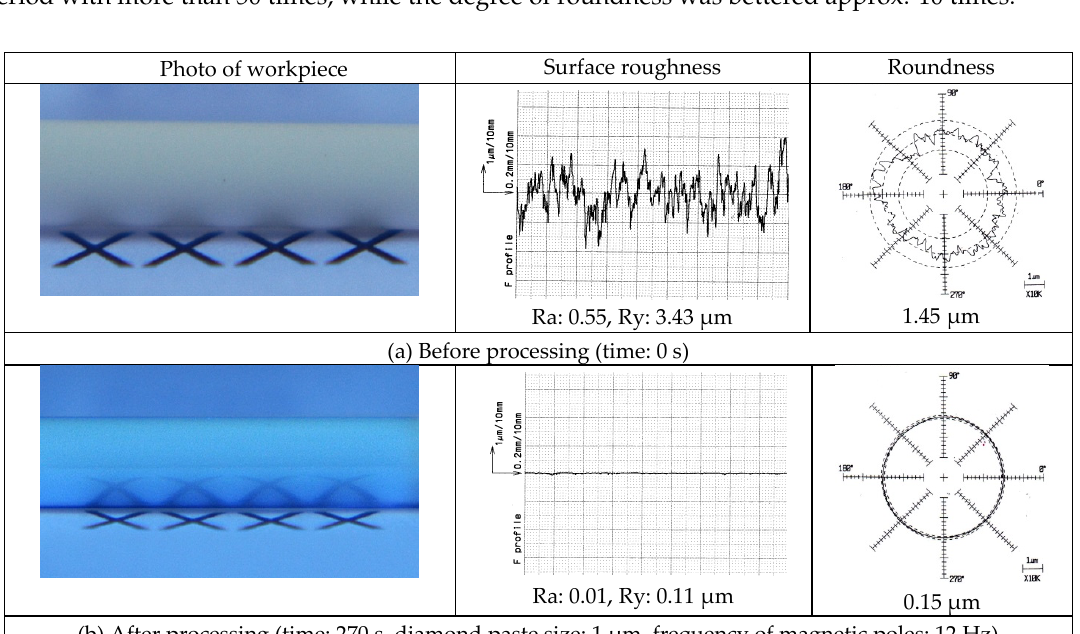
Figure 15. Surface conditions after ultra-precision processing.